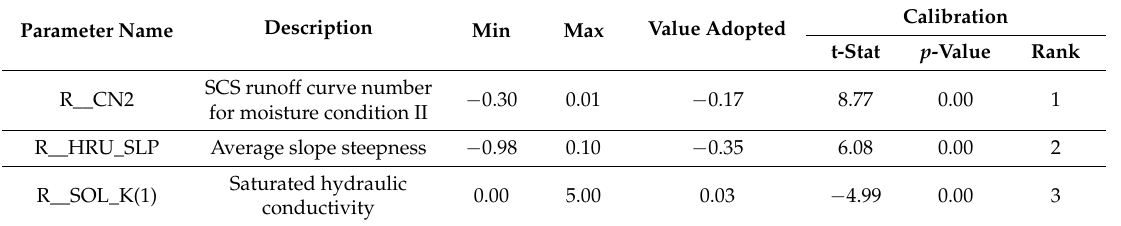
Table 3. Ranking of the most sensitive parameters and their daily simulation variation